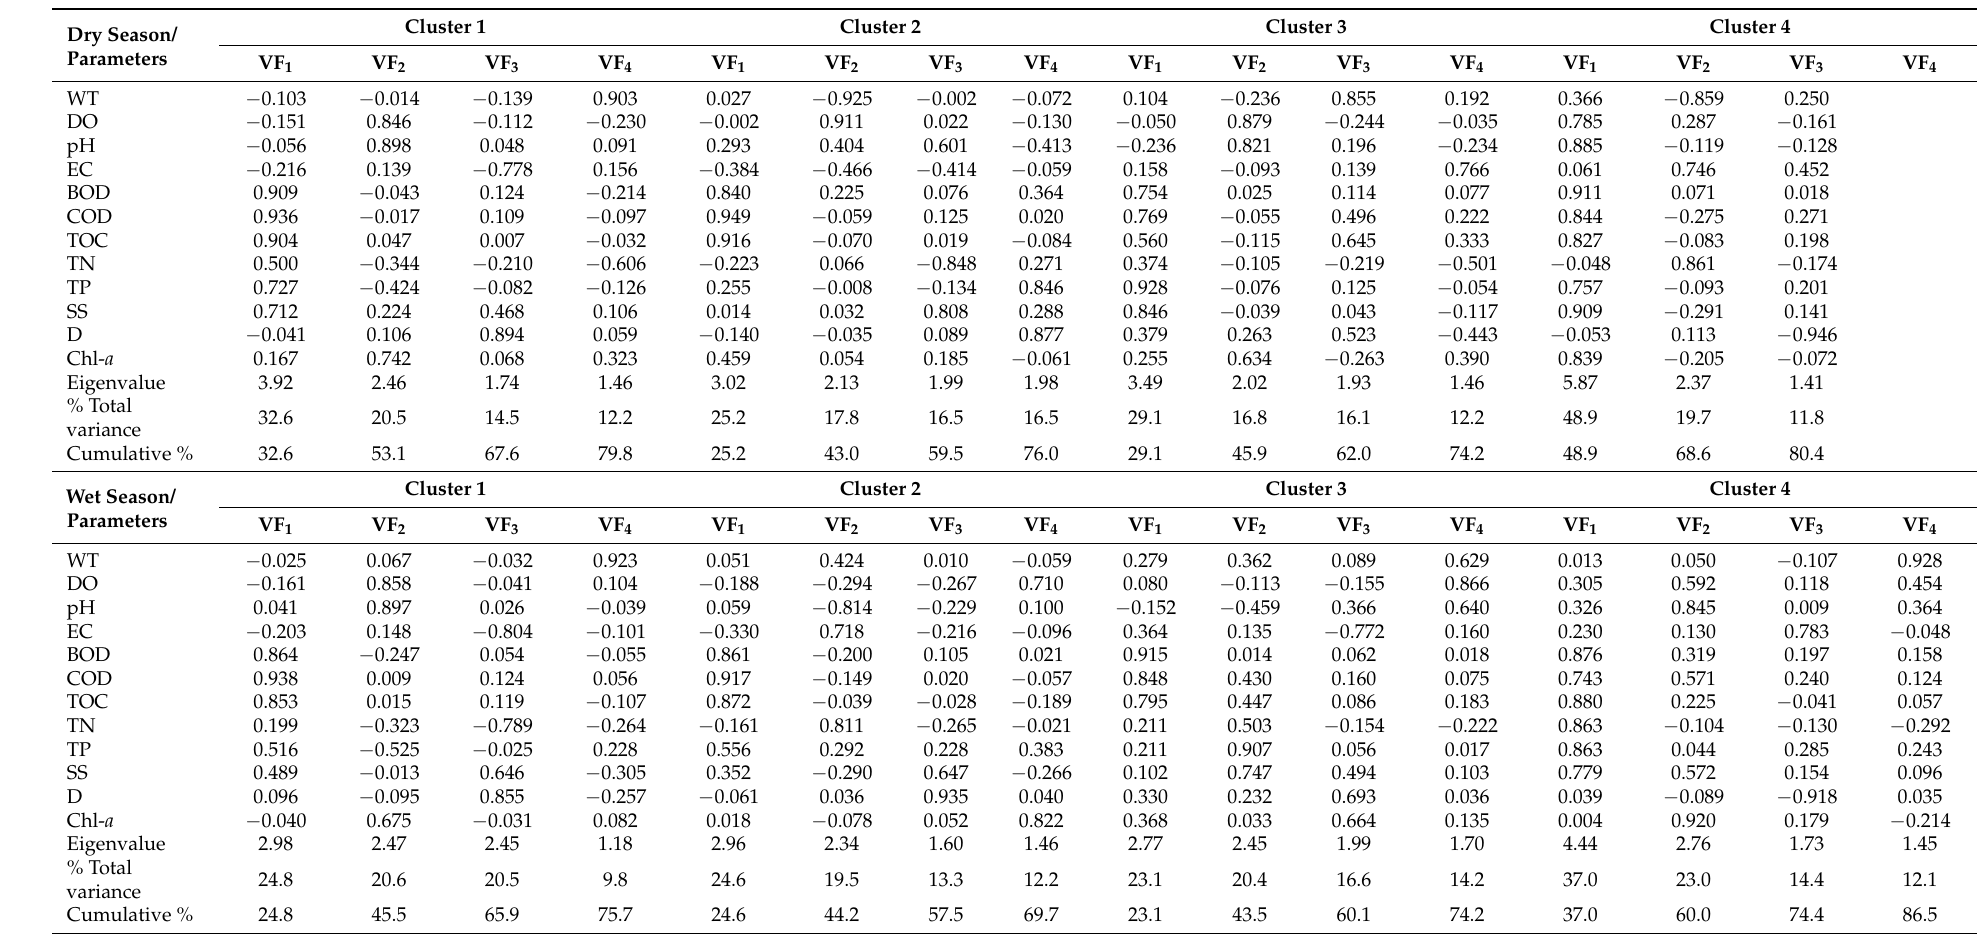
Table 2. Loadings of twelve variables on VARIMAX rotated factors in the dry and wet